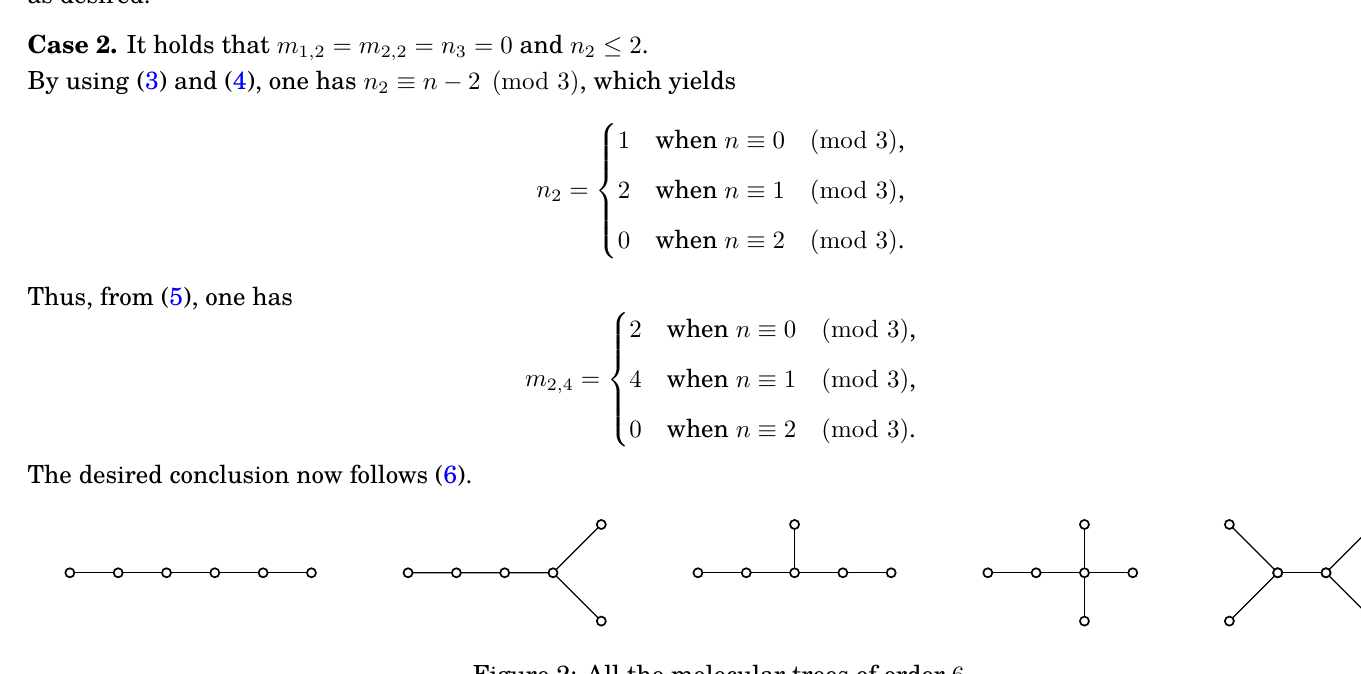
Figure 2: All the molecular trees of order 6